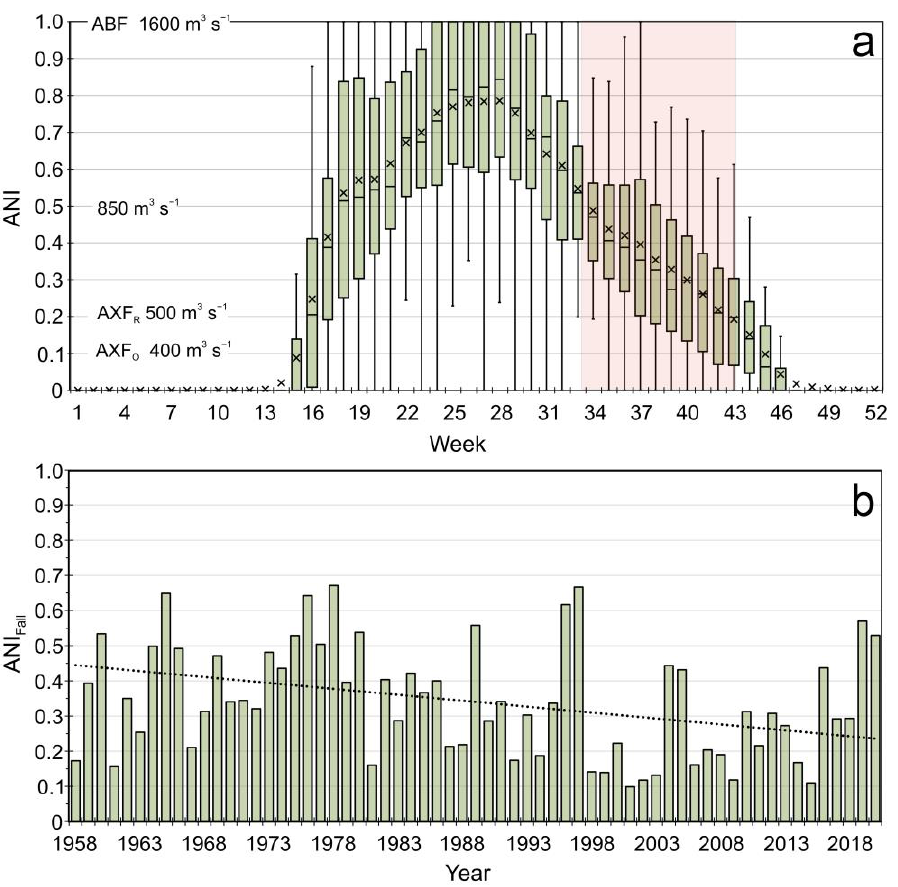
Figure 6. Observed historical ( a ) weekly Aboriginal Navigation Index (ANI) with the fall period (weeks 34–43) highlighted in red and ( b ) annual Fall Aboriginal Navigation Index (ANI Fall ) time series with significant (Sen’s slope) trend line ( p < 0.05; β = −0.003 y −1 ) drawn through the data 1958–2020. ABF, AXF O , and AXF R are Aboriginal Base Flow and original and revised Aboriginal Extreme Flow, respectively.